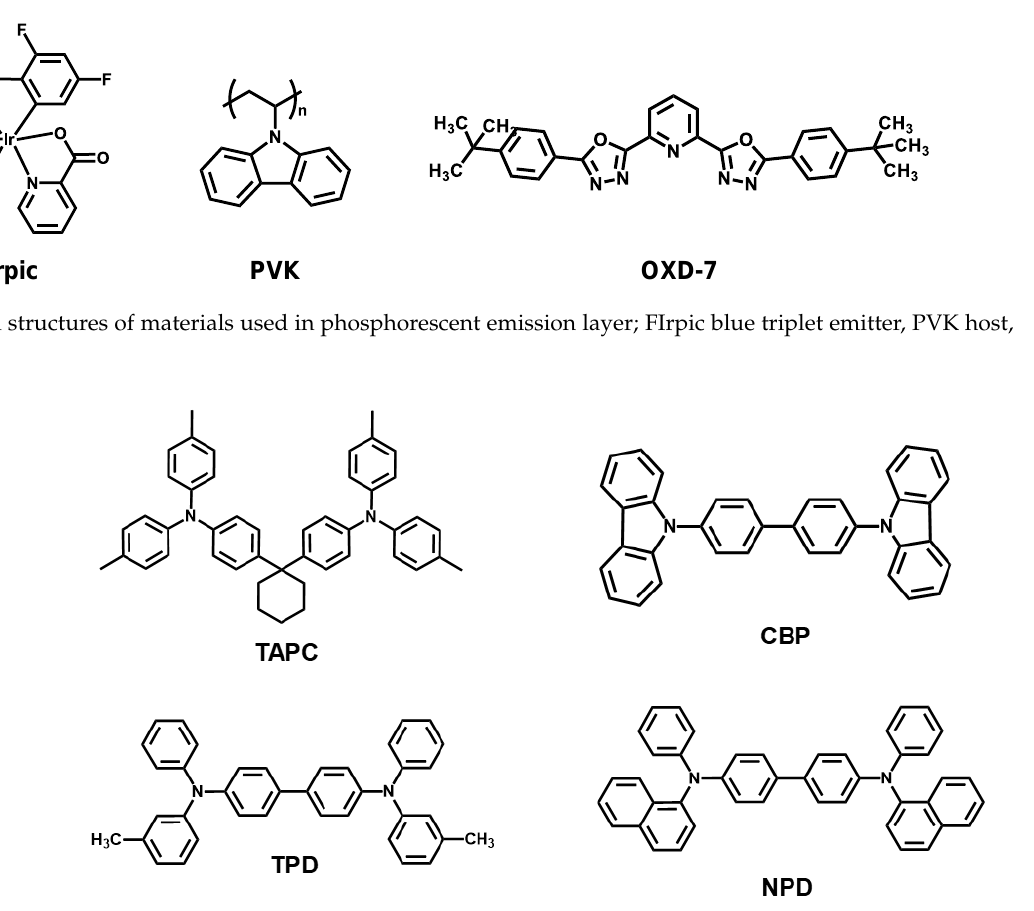
Figure 2. Chemical structures of various hole-transport materials incorporated in the EML.